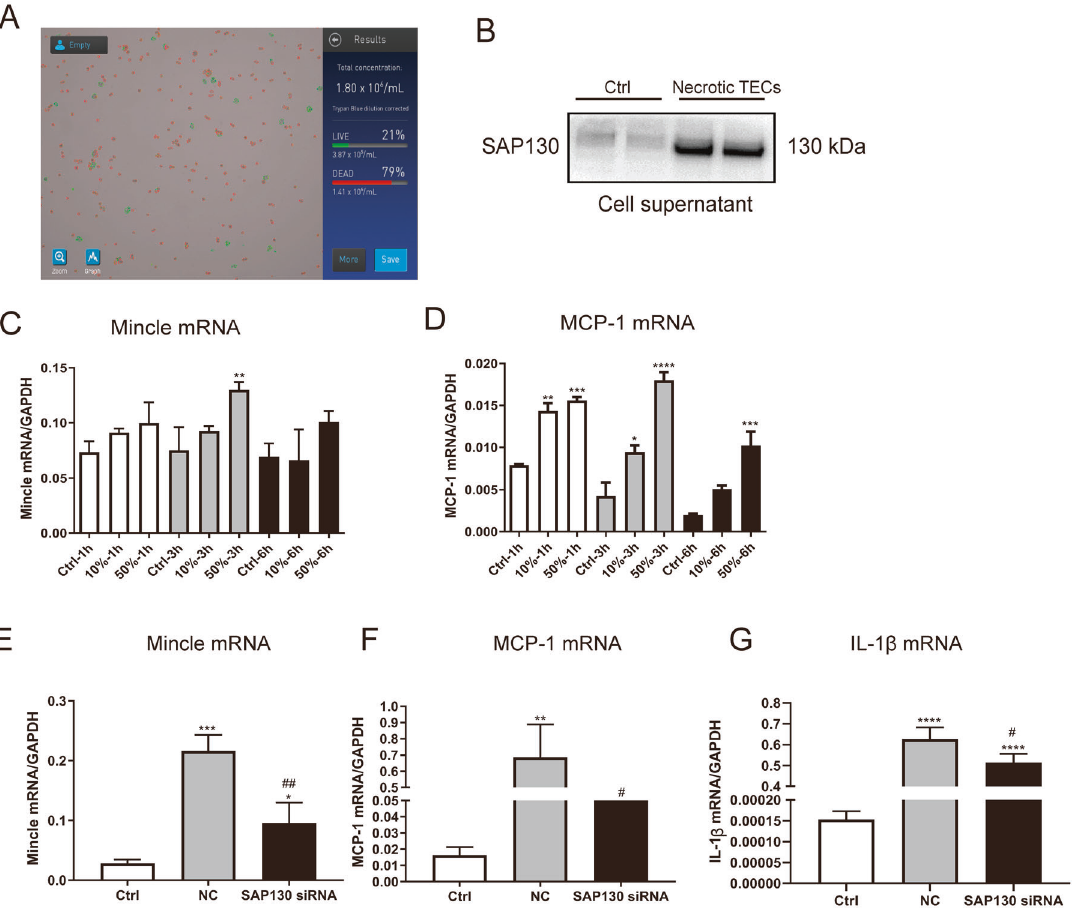
Fig. 3 Dead tubules provoke Mincle and proin fl ammatory cytokine expression in macrophage via SAP130. A Dead cells were stained by Trypan blue and detected by Countess ™ II FL Automated Cell Counter. B SAP130 was detected in the supernatant of dead tubule epithelial cells (TECs) induced by heat stress, while expression was barely detected in normal cells. C – D Mincle and MCP-1 expression was induced in a dose and time-dependent manner in macrophages treated with SAP130-enriched supernatant of dead TECs. E – G SAP130 siRNA transfection reversed the proin fl ammatory effect caused by dead TECs. Data were presented as mean ± SD. * p < 0.05, ** p < 0.01, *** p < 0.001, and **** p < 0.0001 compared to Ctrl. # p < 0.05, ## p < 0.01 compared to NC. Ctrl Control, NC Scramble negative